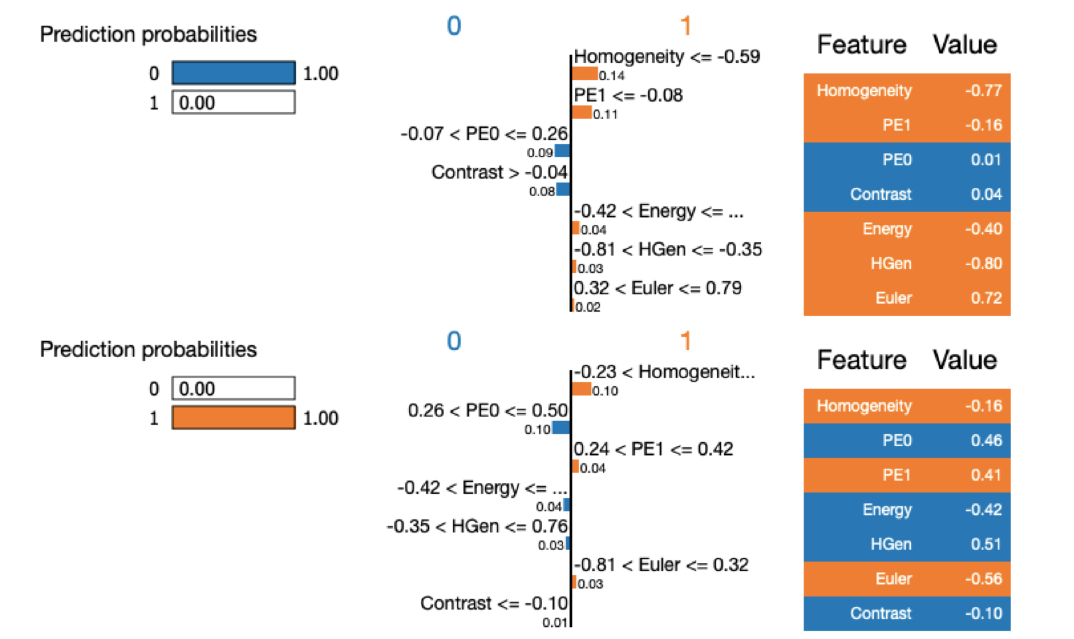
Figure 17. Example of local features relevance analysis for two different samples in the test set w.r.t TPOT prediction.